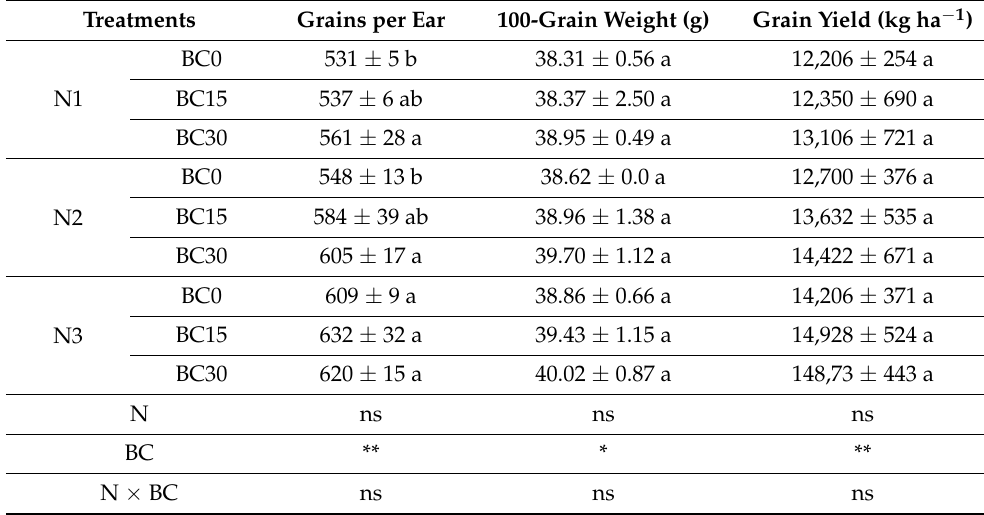
Table 4. Changes of maize grain yield with different nitrogen fertilizer and biochar treatments.